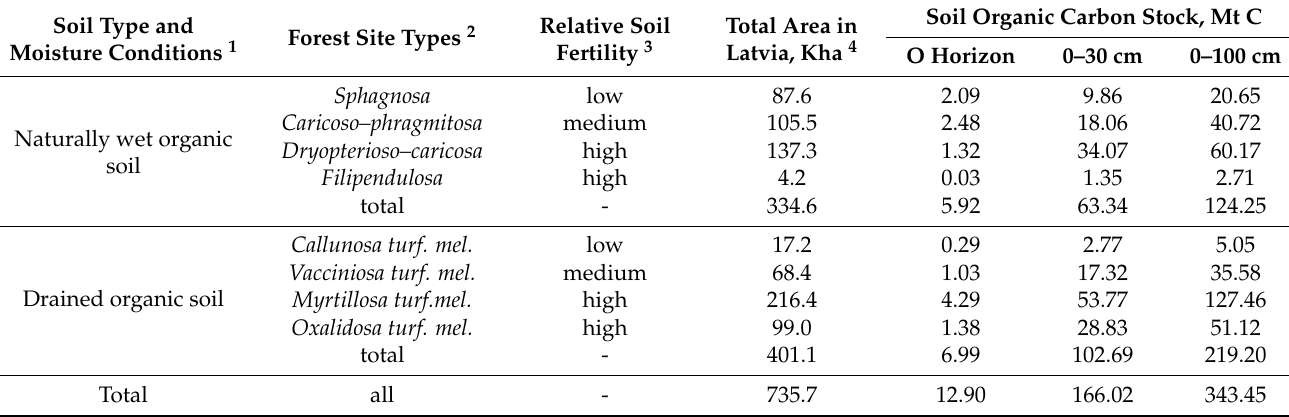
Table 2. National-level assessment of soil organic carbon stock in the O horizon, in the 0–30 cm layer and in the 0–100 cm layer in forest land with organic soils in